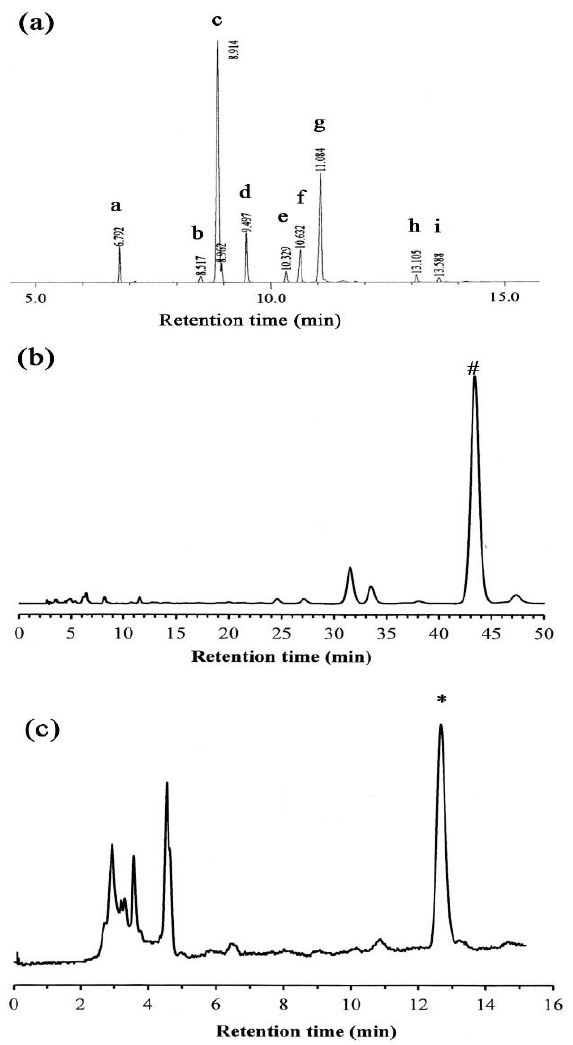
Figure 2. ( a ) Total ion chromatograms of S. mukorossi seed oil tested in this study. ( b ) δ -tocopherol and ( c ) β -sitosterol fractions from high-pressure liquid chromatography. # and * indicated the detected peaks of δ -tocopherol and β -sitosterol, respectively.